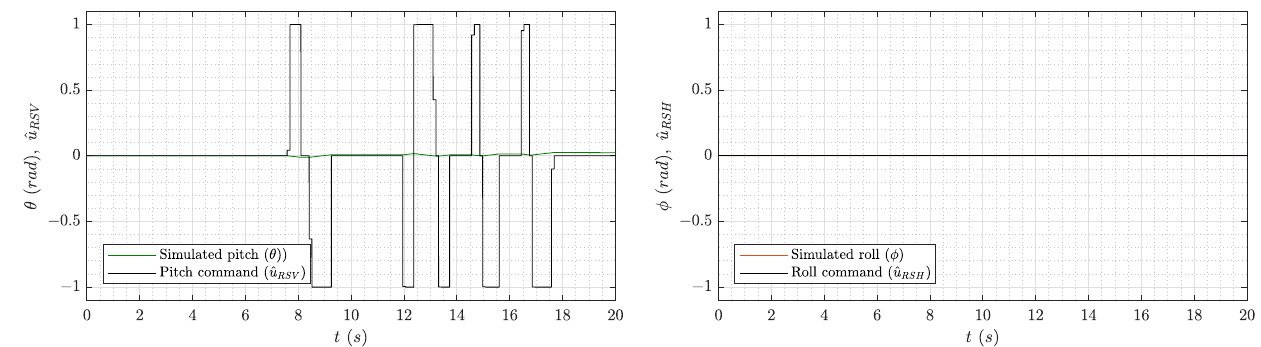
Figure 10. The data retrieved from the virtual simulator using the experimental input commands from th GameSir T1d controller.